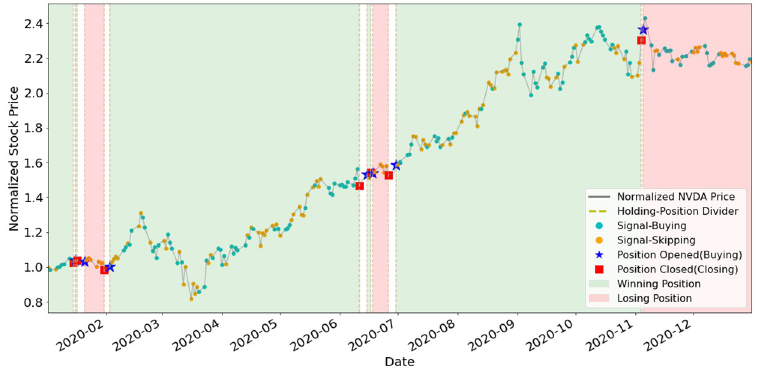
Fig 14. Signals and position-holding of NVDA’s EAM.